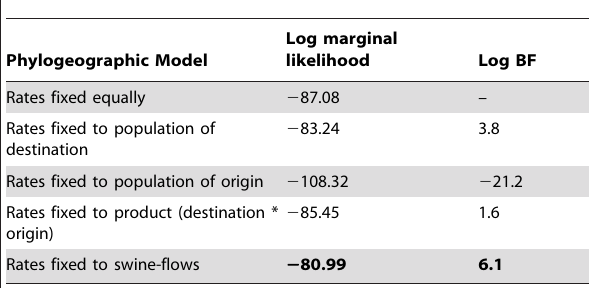
Table 3. Best-fit phylogeographic